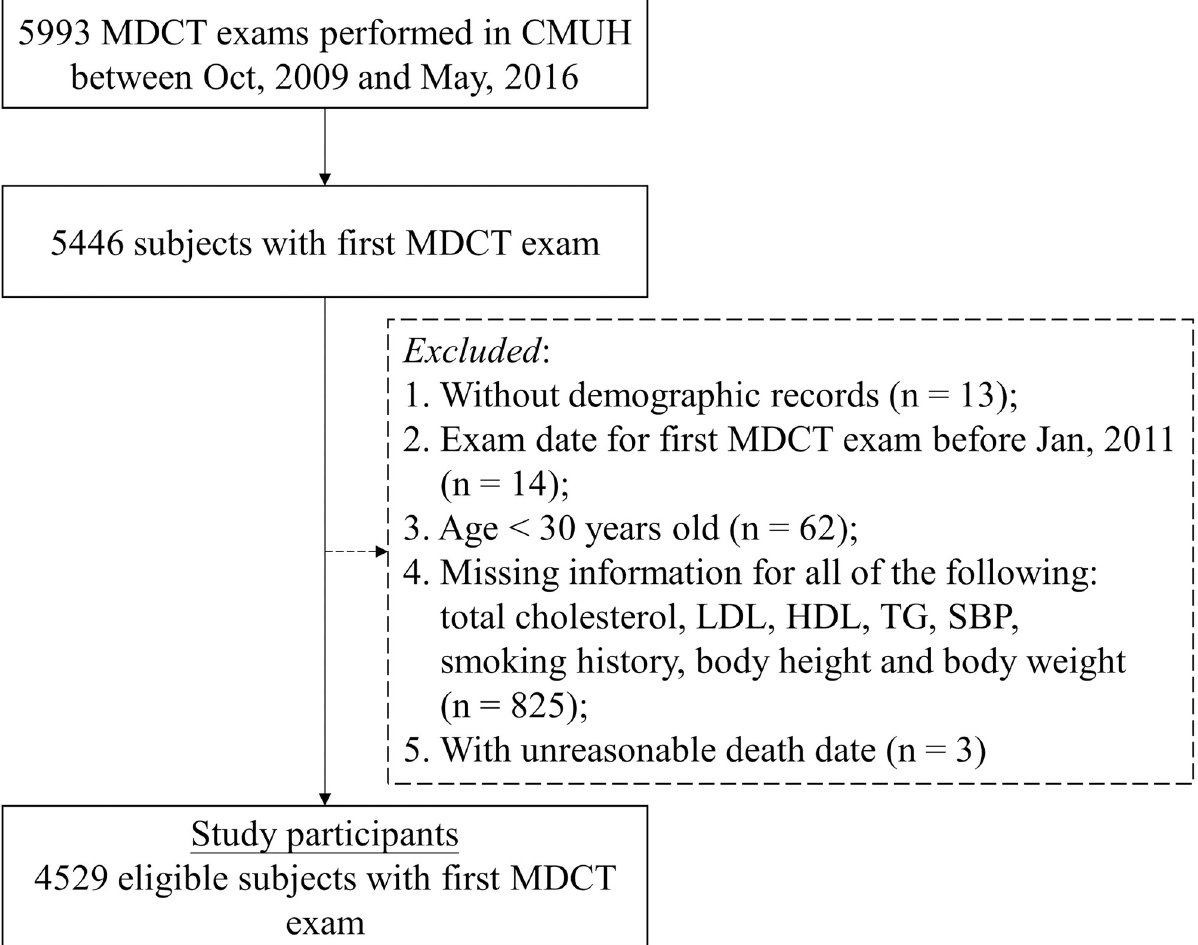
Fig 1. Selection process of the study population. MDCT, multidetector computed tomography; CMUH, China Medical University Hospital; CRDR, Clinical Research Data Repository; TCHO, total cholesterol; HDL, high-density lipoprotein; LDL, low-density lipoprotein; TG: triglyceride; SBP, systolic blood